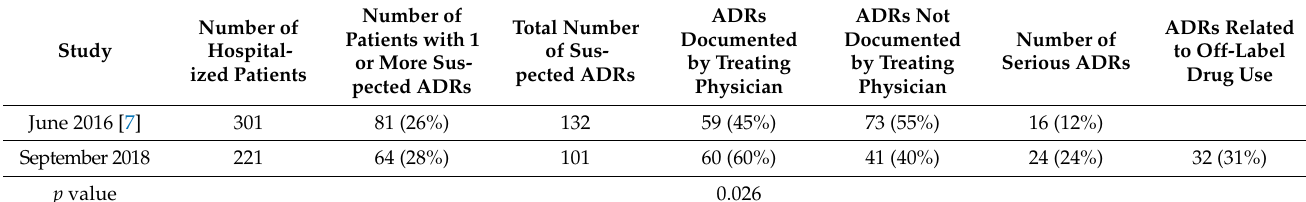
Table 1. Comparison of the number of ADRs found in the two studies, showing the effect of creating awareness, number of serious ADRs, and the number of ADRs due to off-label